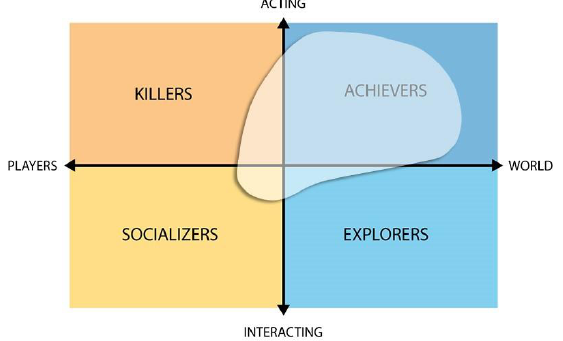
Figure 5. Current